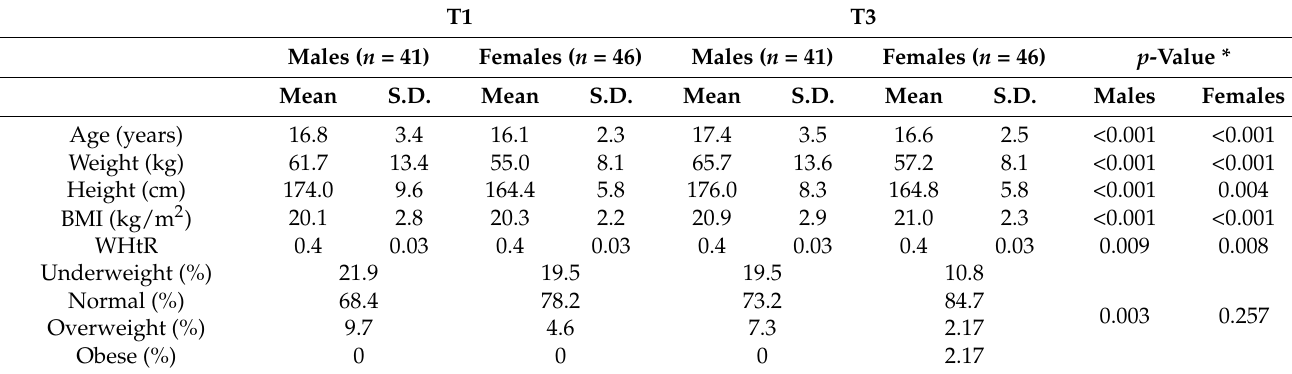
Table 2. Anthropometric characteristics of males and females at T1 and